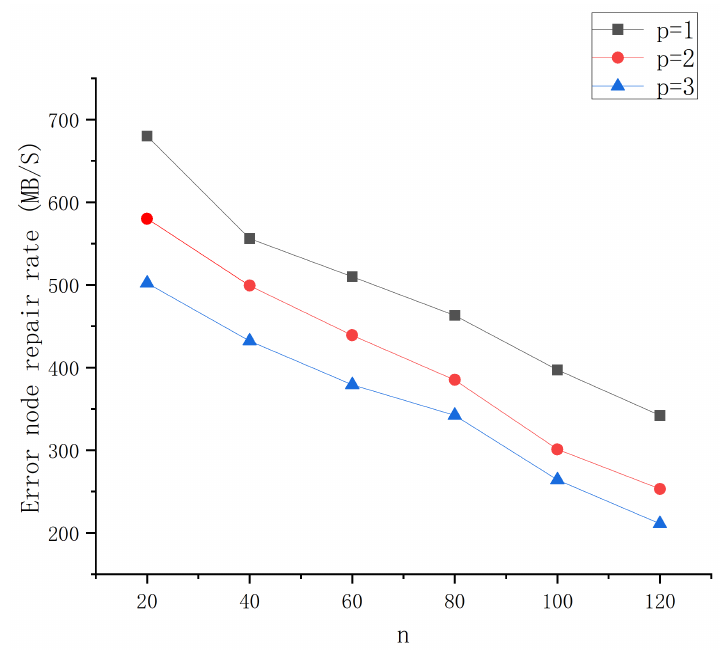
Figure 4. Error node repair